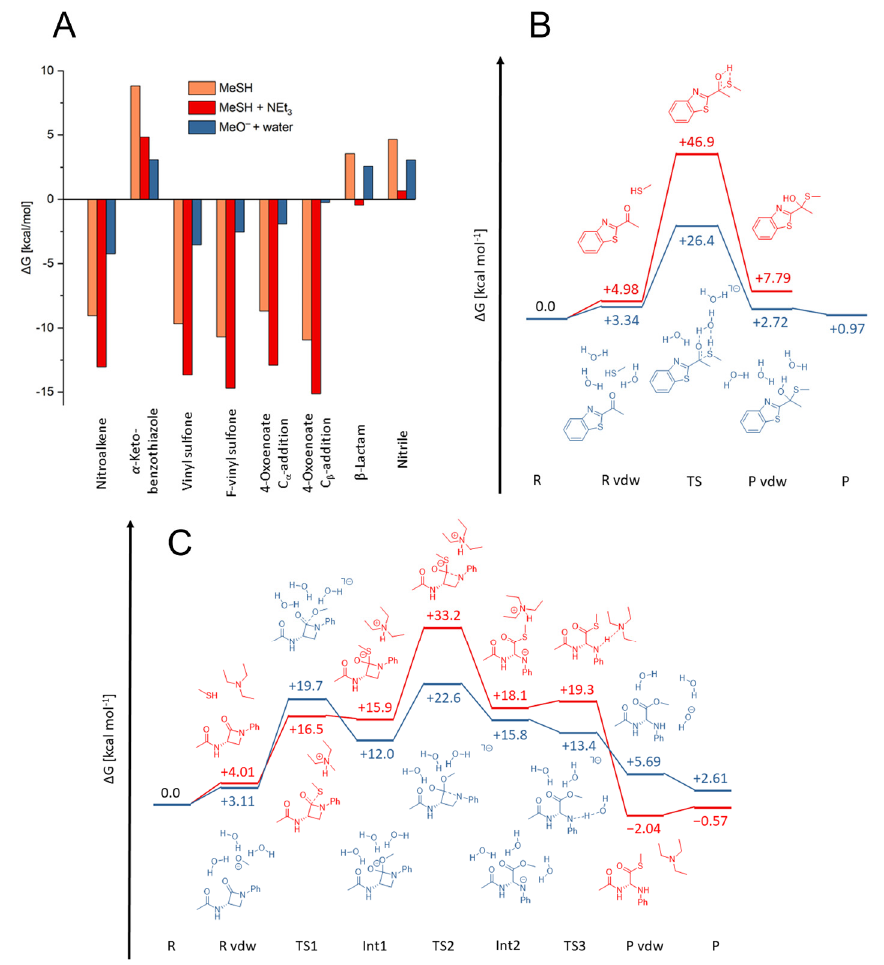
Figure 5. ( A ) Free energies of the reactions for all inhibitor warheads with MeSH, MeSH + Et 3 N and MeO − + 3H 2 O, computed as described in the Supplementary Materials section and Figures S24 by ω B97X − D/6 − 311++G**// ω B97X − D/6-31+G* calculations. ( B ) Free energy reaction paths of the α -ketobenzothiazole warhead with MeSH (red) and with MeSH in the presence of three water molecules (blue). For MeSH (red), the van der Waals complex (P vdw) and separated product molecules (P) are identical since the reaction yields only a single product molecule. For MeSH + water (blue), the energies are referenced on MeSH + 2H 2 O and the α -ketobenzothiazole warhead + H 2 O (R). ( C ) Free energy reaction paths of the β -lactam warhead with MeSH + NEt 3 (red) and with MeO − in the presence of three water molecules (blue). The reaction proceeds in three consecutive steps: first, nucleophilic attack at the amide carbonyl group (TS1); second, the opening of the lactam ring (TS2); and third, the proton transfer from the base (NEt 3 or H 2 O) to the former amide nitrogen